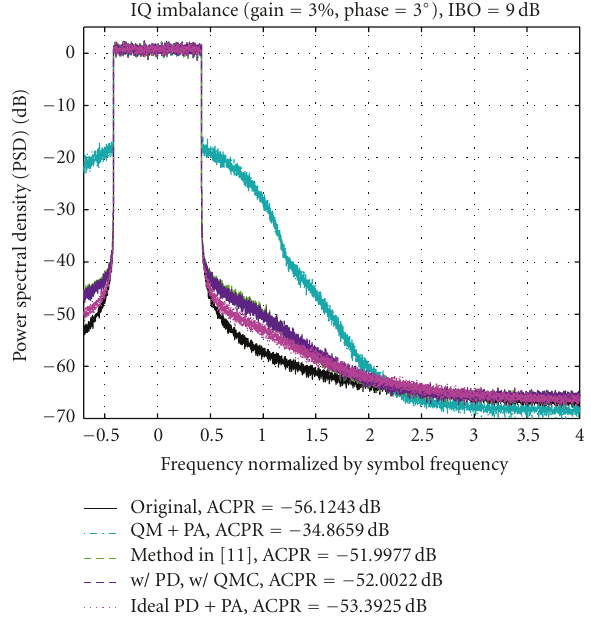
Figure 14: ACPR performance of the MOP PD with and without the proposed IQ imbalance